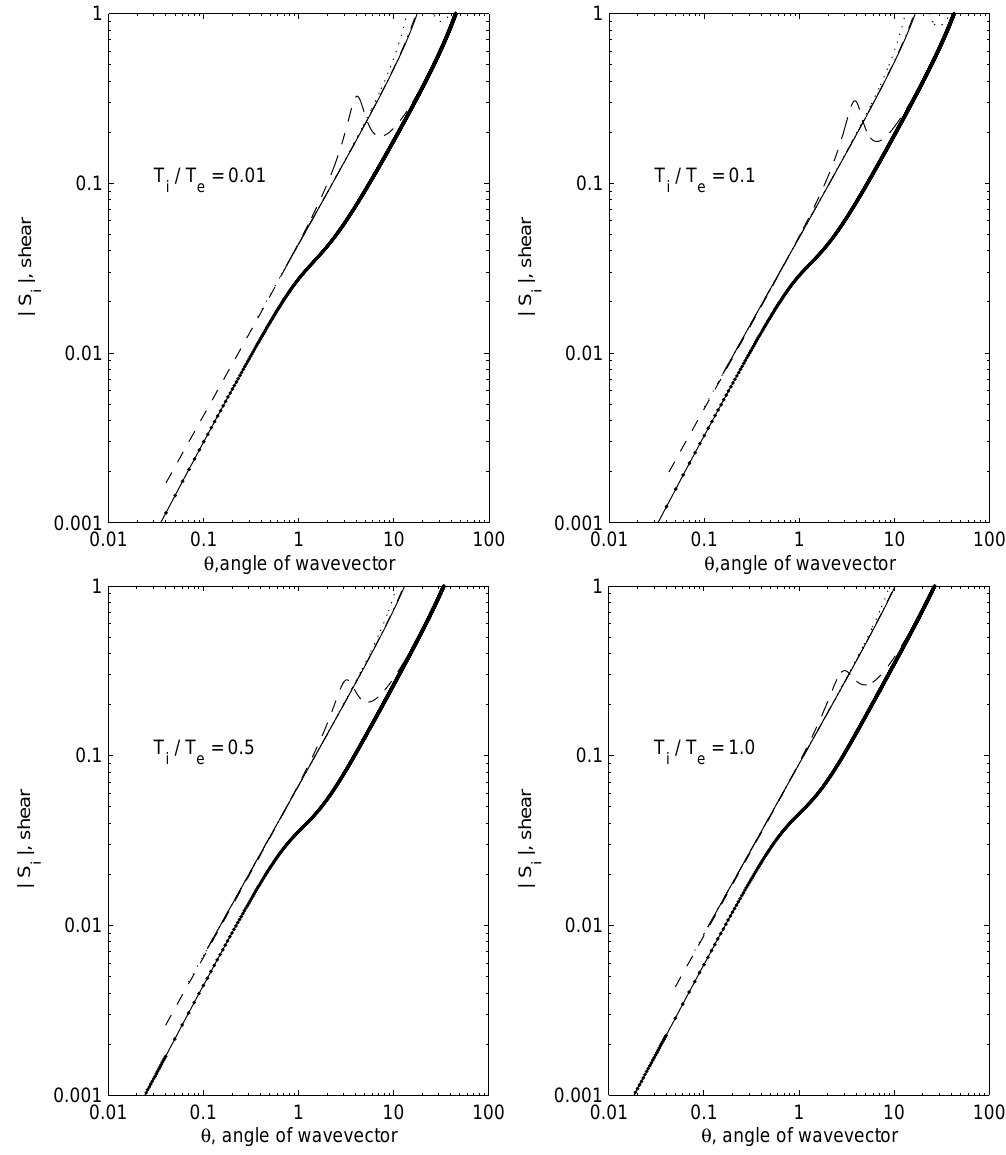
Fig. 5. Velocity shear as a function of wavevector angle for the case described in Fig. 3. The angle is 0 ◦ when the angle is perpendicular to B and 90 ◦ when parallel to it. The line scheme is the same as in Fig.